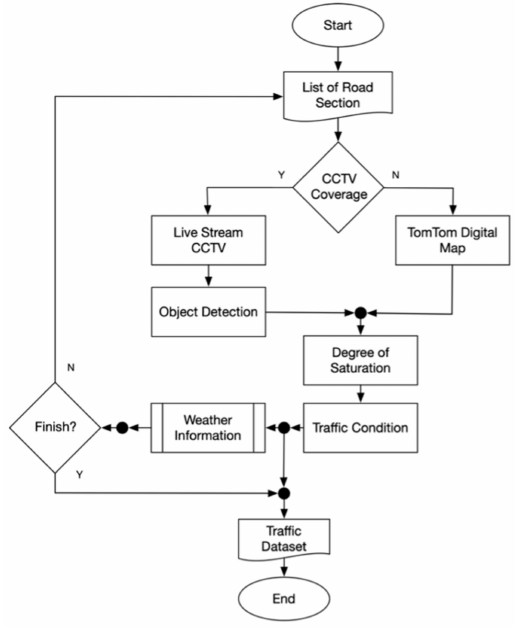
Figure 2. The proposed traffic dataset collection